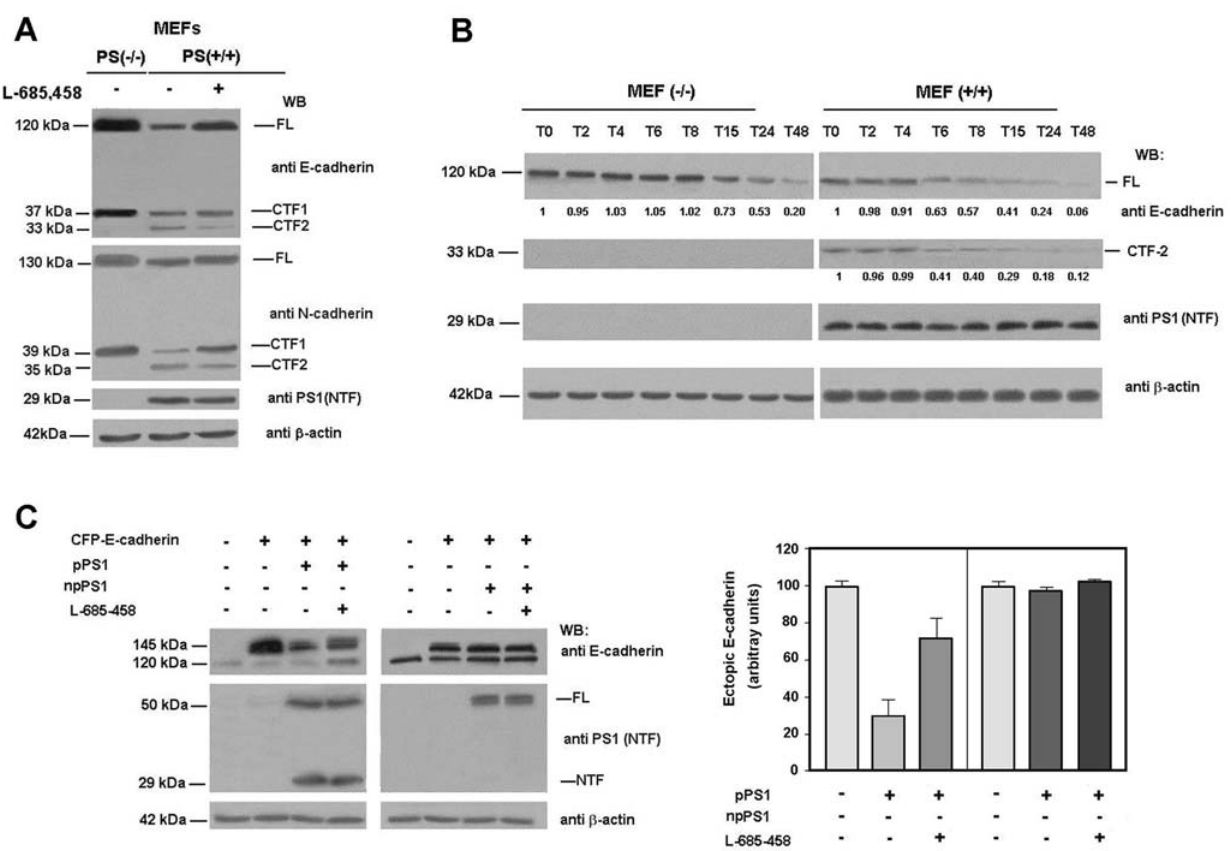
Figure 4. pPS1, and not npPS1, is responsible for down-regulation of E-cadherin levels. (A) MEF PS ( + / + ) cells were incubated with 5 m M c -secretase inhibitor L-685,458 for 24 h. 50 m g of MEFs PS ( 2 / 2 ) and PS ( + / + ) total cell extracts were analyzed by SDS-PAGE and Western blot with the indicated antibodies. (B) MEF PS ( 2 / 2 ) and PS ( + / + ) cells were incubated with 25 m g/ml cycloheximide for the indicated time periods. 10 m g of MEF PS ( 2 / 2 ) and 60 m g of MEF PS ( + / + ) total cell extracts were analyzed by Western blot with anti-E-cadherin, anti-PS1 (N-terminus) and anti- b -actin- specific antibodies. Autoradiograms were scanned; the values obtained for E-cadherin were referred to the initial time. (C) MEF PS ( 2 / 2 ) cells were cotransfected with 2.5 m g of pECFPN1-E-cadherin and 2.5 m g of pcDNA3.1- Myc/His -PS1 (npPS1) or pcDNA3.1-PS1 (pPS1) plasmids. 24 h after transfection, 5 m M c -secretase inhibitor L-685,458 was added to the medium for 24 h. Percentage of transfection was estimated to be approximately 80%, determining the number of CFP-positive cells. 50 m g of total cell extracts were analyzed by Western blotting with the indicated antibodies. At the right, the ectopic E-cadherin levels of three different experiments were quantified and represented with respect to control (no expression of either pPS1 or npPS1). Values are the average + / 2 S.D. of these experiments.